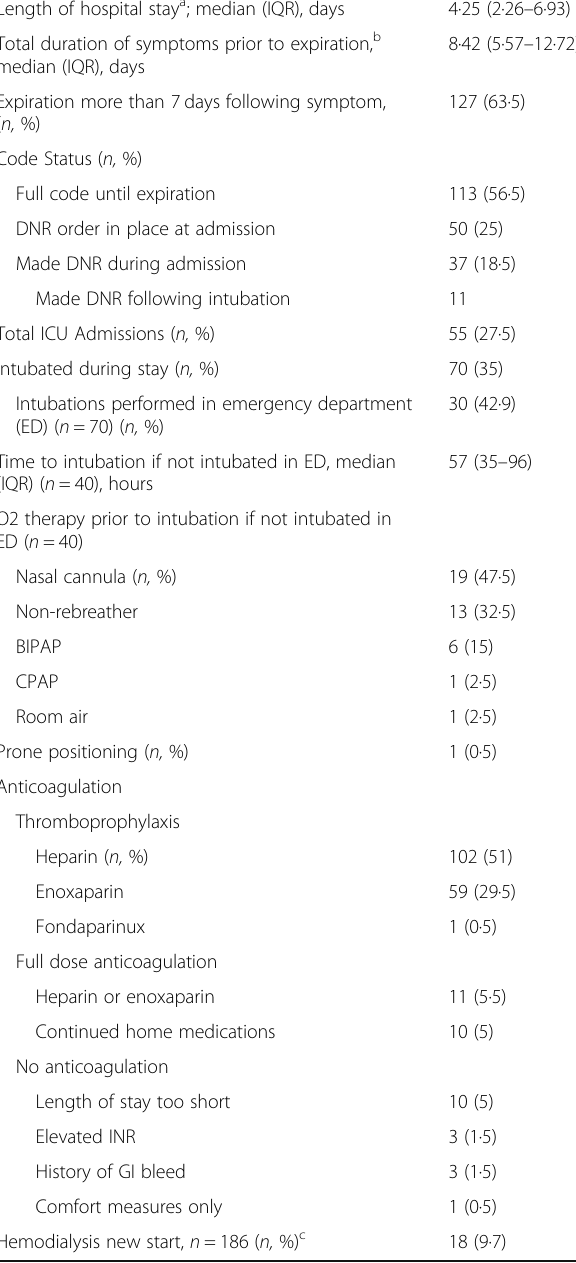
Table 4 Lab values on expiration Table 5 In-hospital management ( n =